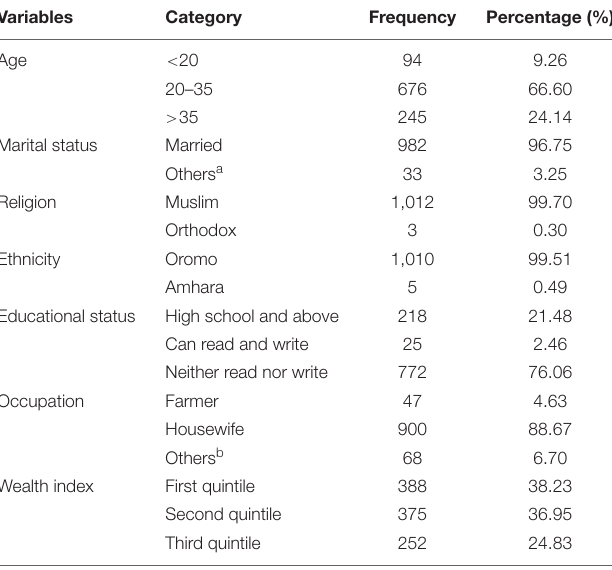
TABLE 1 | Socio-demographic and economic characteristics of pregnant